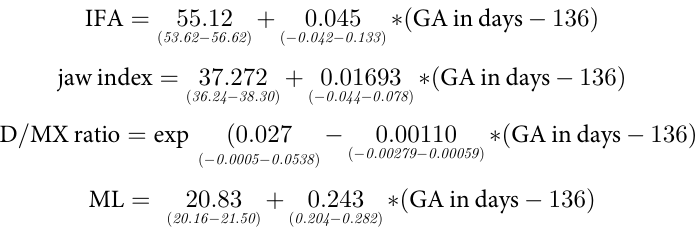
hospitals. No women had home birth. None of the newborns was suspected of any structural or genetic abnormalities after physician’s examination. Finally, all 291 women who delivered structurally normal neonates were included in the analysis (Fig 5). The demographic data and obstetric outcomes are shown in Table 1. As there were some incomplete measurements of some parameters due to improper fetal position or thick maternal abdominal wall, the percent- ages of successful measurements of the IFA, jaw index, MD/MX ratio and ML were 93.8%, 98.3%, 87.3% and 99.7%, respectively. Scatter plots demonstrating the IFA, jaw index, MD/ MX ratio and ML measurements across GA are shown in Figs 6 to 9, respectively. The IFA, jaw index and ML values significantly increased while the MD/MX ratio value significantly decreased with gestational age. The distributions at the 5th to 95th percentiles for IFA, jaw index, MD/MX ratio and ML for each gestational age are shown in Tables 2 to 5, respectively. Quantile regression was used to construct formulas predicting the 5th percentile value for each parameter. The equations (with 95% CI shown below) are as follows: